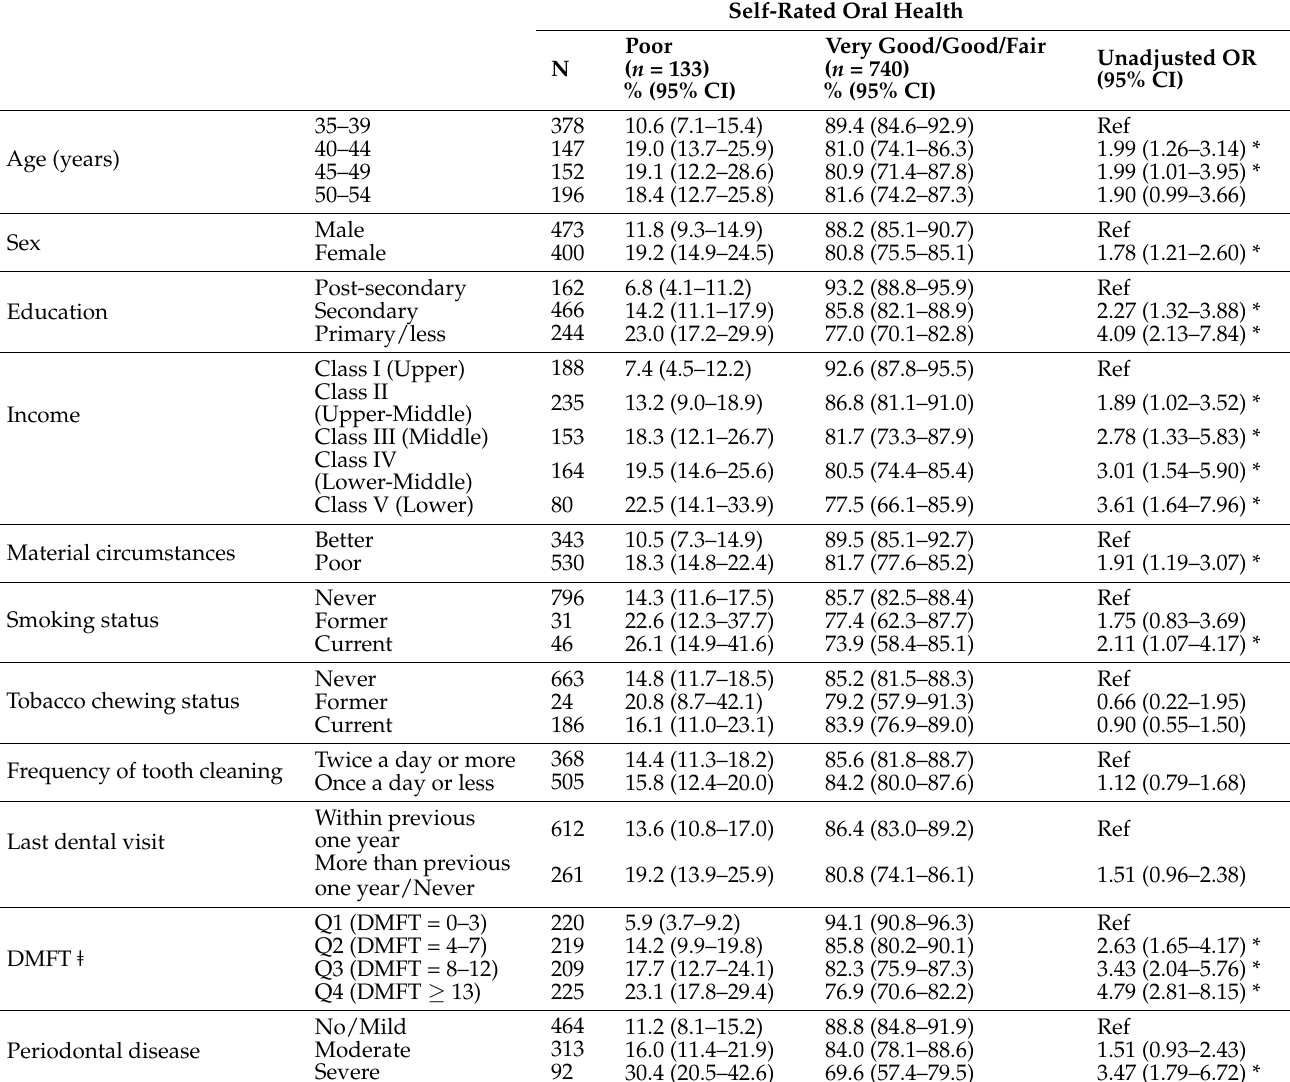
Table 1. Distribution of sociodemographic factors, habits, oral health status, and behaviour according to self-rated oral health in the study population and unadjusted association of various factors with poor self-rated oral health.